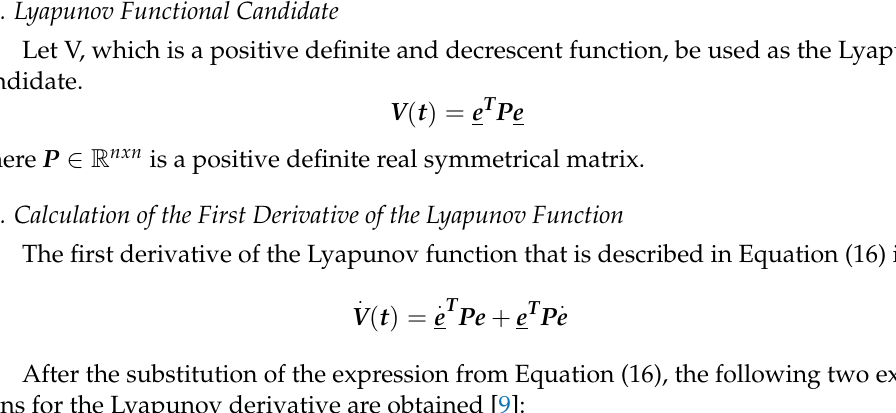
Figure 2. Overall structure of the Lyapunov-based trajectory tracking controller.